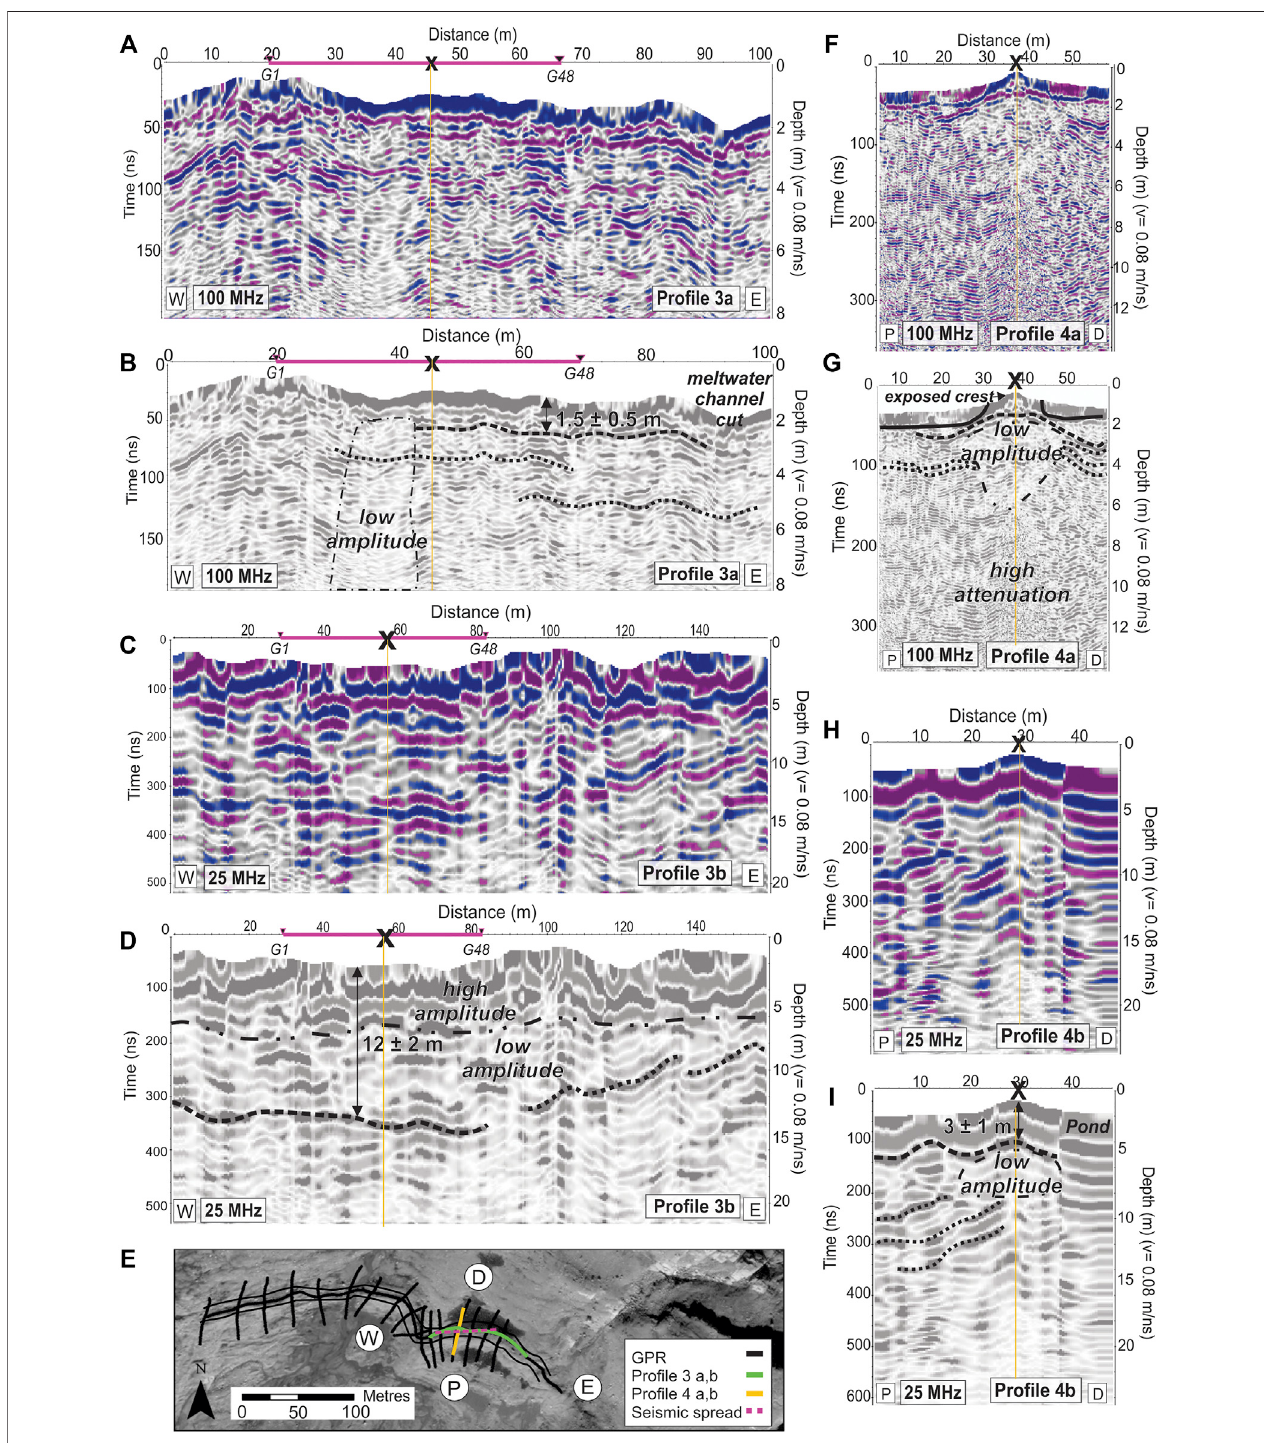
FIGURE 5 | Processed GPR data from the Terminal Moraine Site. (A) Pro fi le 3a: Eastern end (located on E) of the 100 MHz pro fi le along the crest of the prominent terminal moraine and (B) interpretation. (C) Pro fi le 3b: 25 MHz longitudinal pro fi le, parallel to moraine crest, and (D) interpretation. (E) Pro fi le 4a: 100 MHz transverse pro fi le and (F) interpretation. (G) Pro fi le 4b: 25 MHz transverse pro fi le and (H) interpretation. (I) Satellite image with approximate GPR pro fi le locations de fi ned. W, E, P, and D indicate West, East, ice proximal, and ice distal, respectively. In B, D, F, H, solid lines indicate the snow-ground interface. Dashed lines mark continuous re fl ections, dotted lines delineate discontinuous re fl ections, and dot-dashed lines de fi ne changes in radargram character. G1 and G48 indicate the approximate locations of seismic geophones 1 and 48. X and yellow lines indicate the approximate crossover location of Pro fi les 3 and 4 on the radargrams.